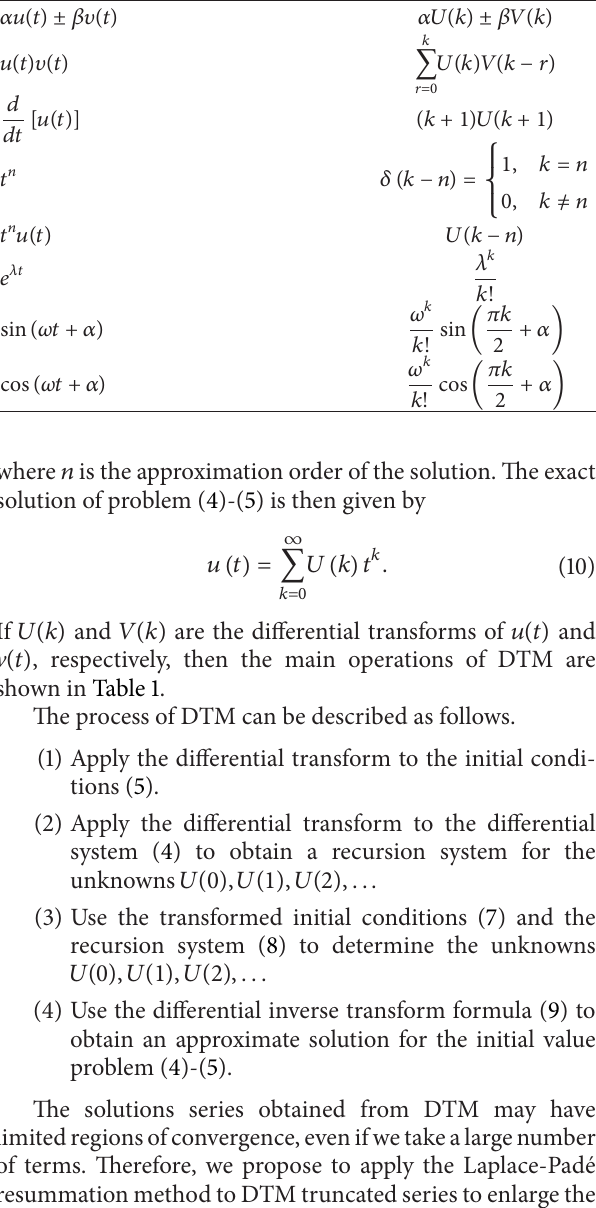
Table 1: Main operations of DTM. Function Differential